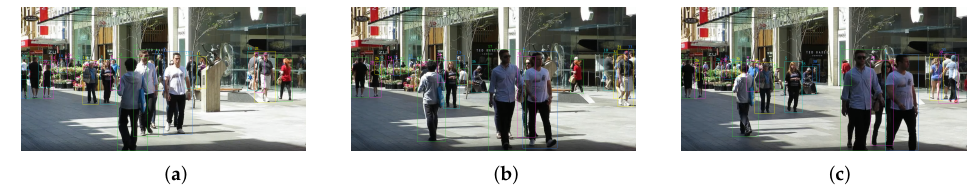
Figure 5. Some examples of tracking results produced by our proposed TdmTracker. Some tracked objects in image ( a ) are occluded in image ( b ), so that they cannot be detected, but when they reappear in image ( c ), they are identified with the ID in image ( a ), which suggests our model can handle short term occlusion.